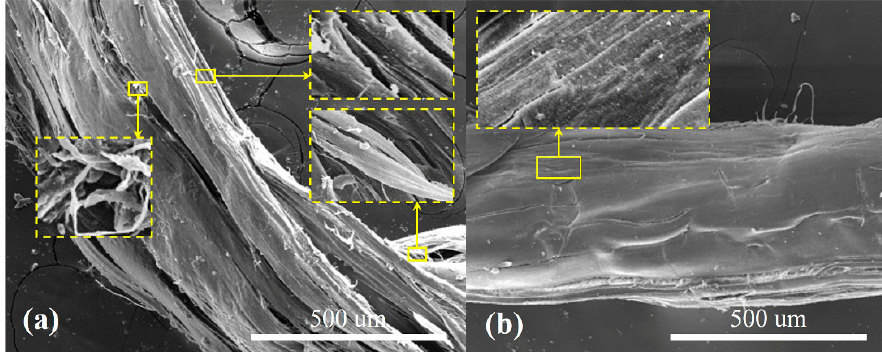
Figure 9. SEM images of PBO-0-TiO 2 fibers ( a ) and PBO-3-TiO 2 fibers ( b ) after exposure to UV-light for 100 h.